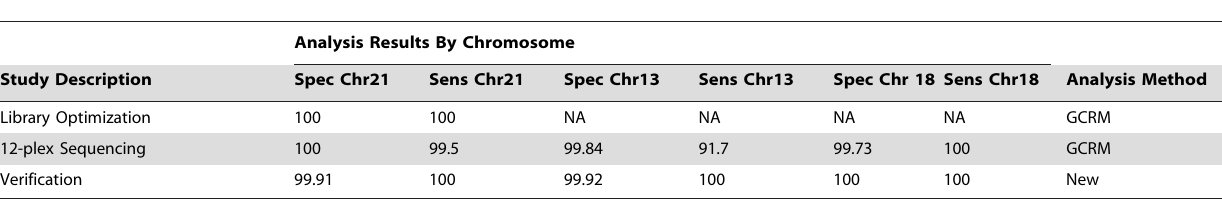
Table 2. Summary of analysis results for each of the studies performed. Sens= sensitivity.